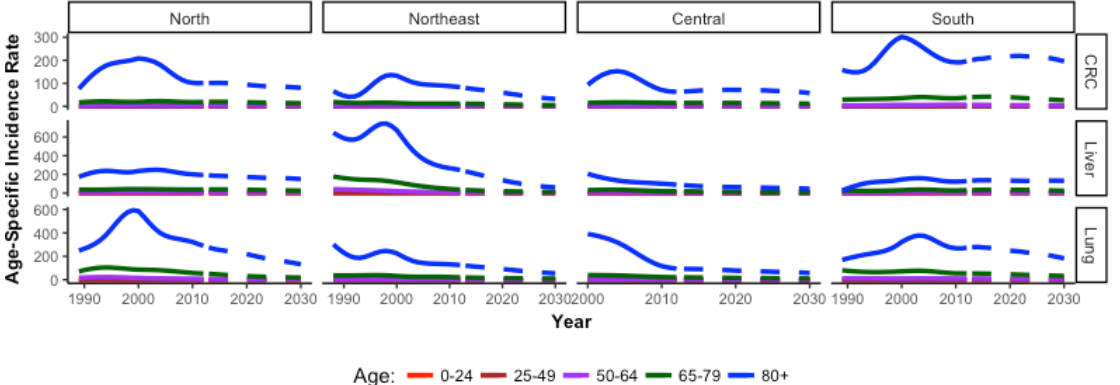
Figure 9. Age-specific incidence rates of each cancer in males only by region. Note the Y -axis are different for each cancer.